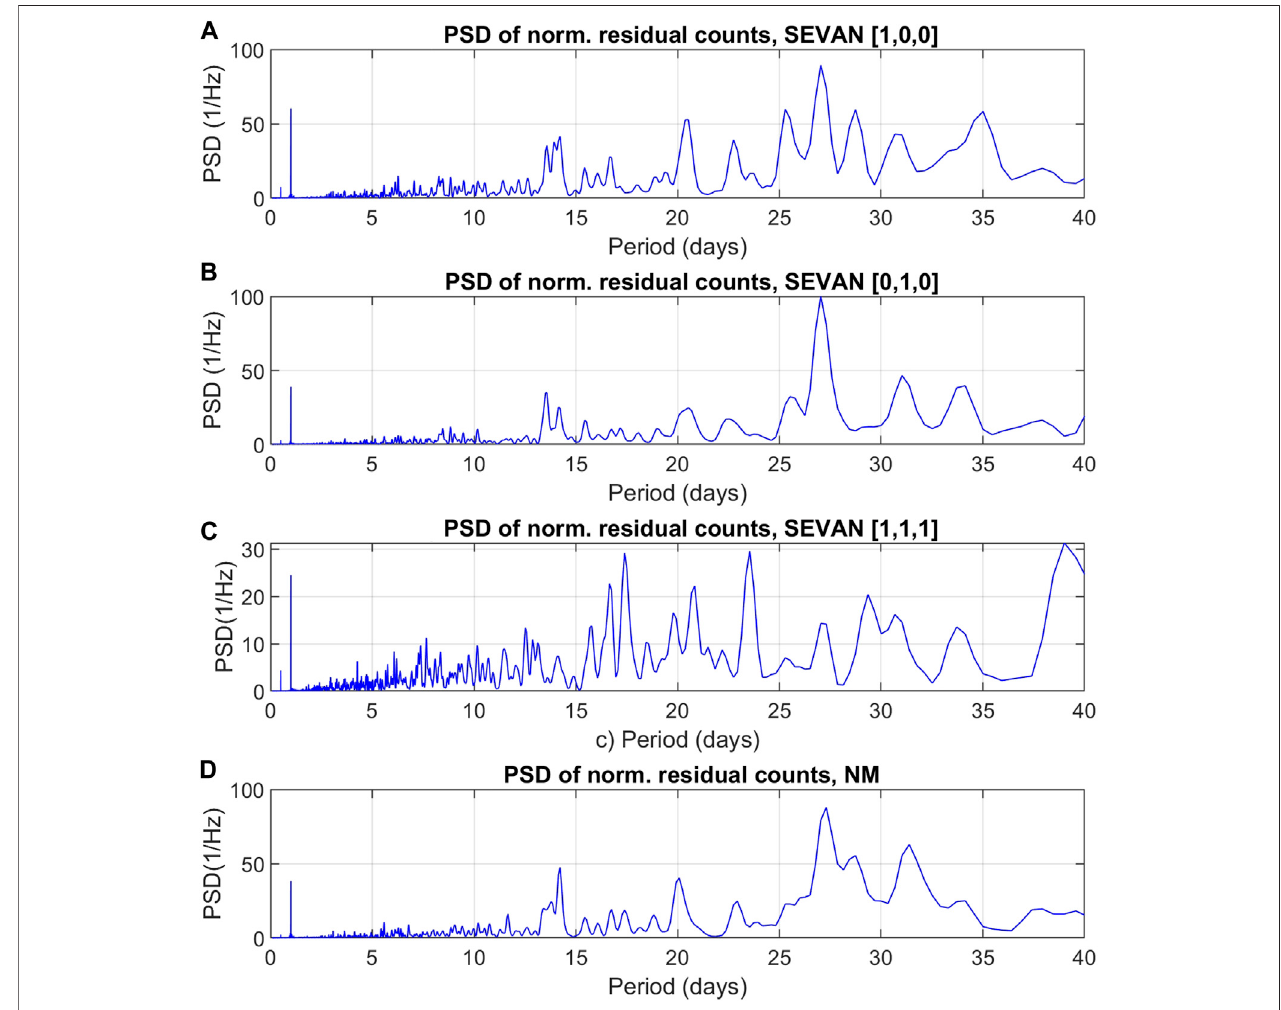
FIGURE 5 | Power spectral densities (PSD) of normalized pressure-corrected counts measured using the SEVAN (A, B, C) and an NM (D) on LS.